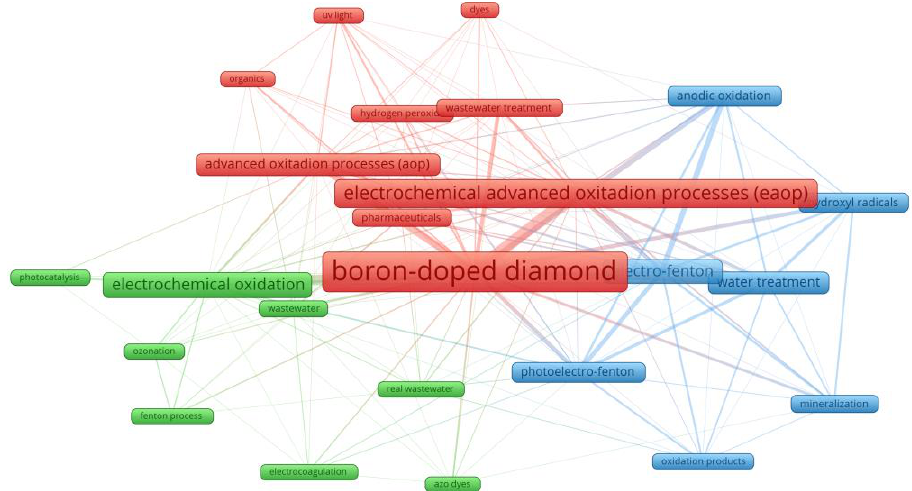
Figure 8. Number of publications per university and research center with more than four publica- tions on EAOPs using diamond technology for water treatment, based on the SLR article selection performed in the Scopus database. Considered period: 2002–2022. Source: the authors.